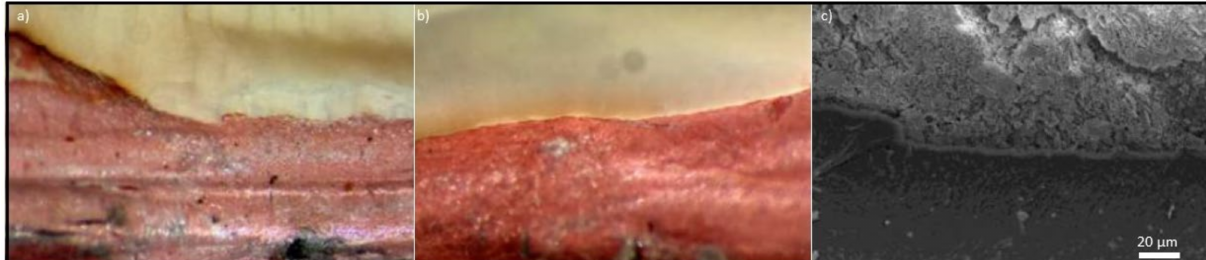
Figure 25. A thin, shimmering layer of sealant evenly covering the resilon after obturation using the thermoplastic condensation method with the THC technique (( a , b )—LSM, ( c )—SEM): ( a ) in the coronary part on the border of the main cone and the complementary material; ( b ) being the border between the root canal wall and the resilon; ( c ) flaps arrangement of the sealant covering resilon and its tight connection with the dentine of the root